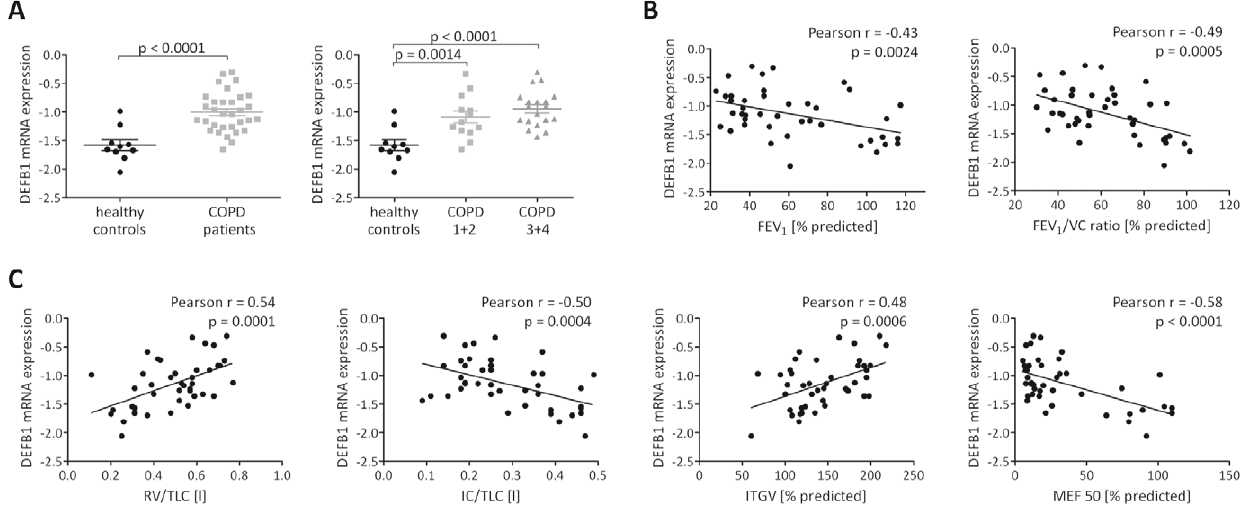
Figure 1. DEFB1 mRNA expression analysis in bronchial epithelial cell biopsies from patients with COPD and healthy controls. ( A ) Expression levels of DEFB1 mRNA in epithelial cell biopsies from patients with COPD (N=34 total, N=15 for COPD 1 + 2, N=19 for COPD 3 + 4) and healthy controls (N=10). Levels of DEFB1 mRNA were quantified by Real-time PCR, variations of transcript levels were corrected by b 2-M mRNA levels and log transformed for statistical analysis. Differences between COPD patients (total) and healthy controls were tested using unpaired t-test. Analysis of variance of three groups was performed with the use of the One-way ANOVA test followed by Tukey’s Multiple Comparison test. When the results were significant, the unpaired t-test was performed for comparison between the groups with differences p , 0.05 considered significant. Results are presented as mean 6 SEM, each symbol represents a single sample. ( B ) Correlations between levels of DEFB1 mRNA and FEV 1 and the ratio FEV 1 /VC and ( C ) correlations between levels of DEFB1 mRNA and the ratios RV/TLC, IC/TLC, ITGV and MEF50 in epithelial cell biopsies from patients with COPD (N=34) and healthy controls (N=10). Analyses in (B) and (C) were performed using Pearson correlations with differences p , 0.05 considered significant. Each symbol represents a single sample. (The complete data and p values are given in supporting information, Table